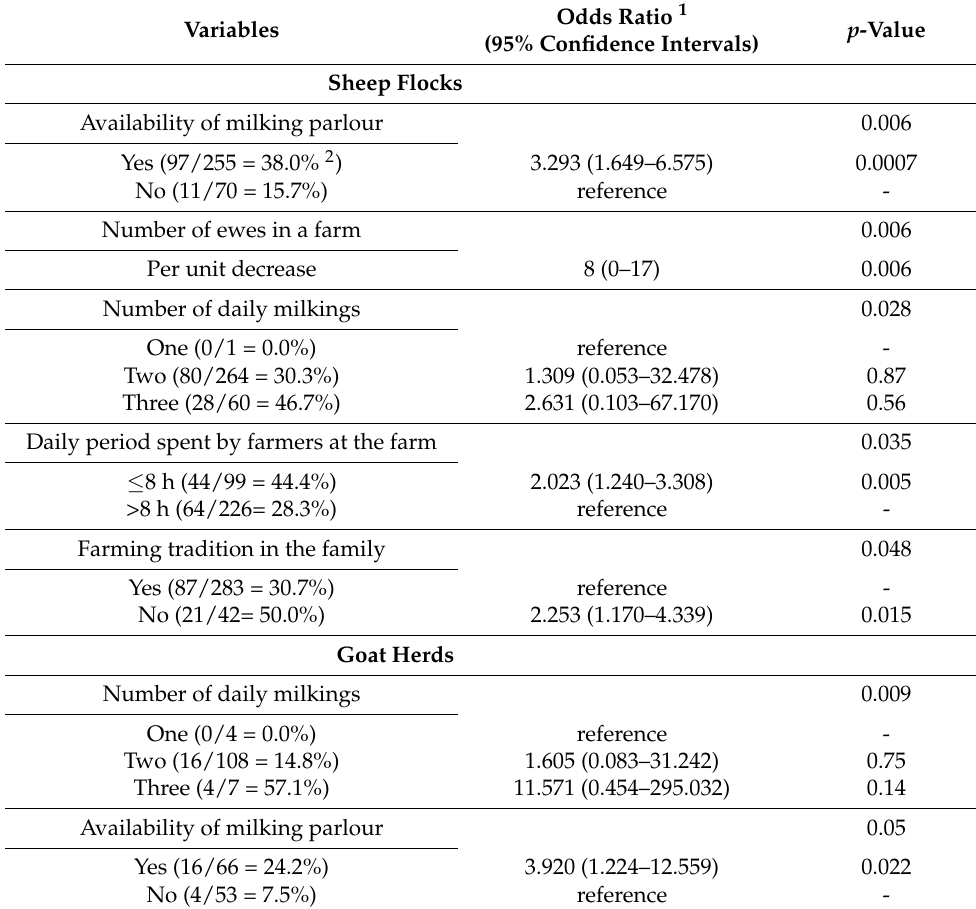
Table 1. Multivariable analysis for predictors for application of reproductive control in sheep and goat farms in